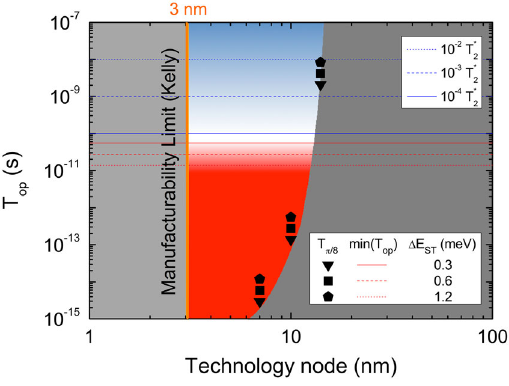
Fig. 5 Physical constraints for QIP with Si hybrid qubits. Technolo- gical limits prohibit quantum computation in the domain of gray areas due to manufacturability limits on the left side (set by the vertical orange line at 3 nm) and by the maximum effective exchange interaction on the right side ( black scatters ). Black data points denote the minimum operation time for a π /8 rotation that can be achieved at each technology node with the realistic values of Δ E ST = 0.3, 0.6, and 1.2 meV. Red lines indicate the minimum operation time imposed by adiabaticity at the same three values of S-T splitting of Δ E ST . Blue lines set the maximum operation time required by coherence requirement at three different error thresholds ( η = 10 − 4 , 10 − 3 , and 10 − 2 errors per logic gate) characteristic of available coding techniques, namely, Steane code, concatenated/color codes, and surface codes, respectively. The ideal dephasing time T ∗ 2 = 1 μ s is taken according to theoretical predictions in ref. 36. The white area represents the optimal regime of operation for QIP with the Si qubit architecture here considered. Reasonable operating frequencies are in the order of 10 GHz, with bandwidth depending on the optimization of the QD parameters ( Δ E ST , t ) and of the QEC scheme compatibility with the requirements of coherence and